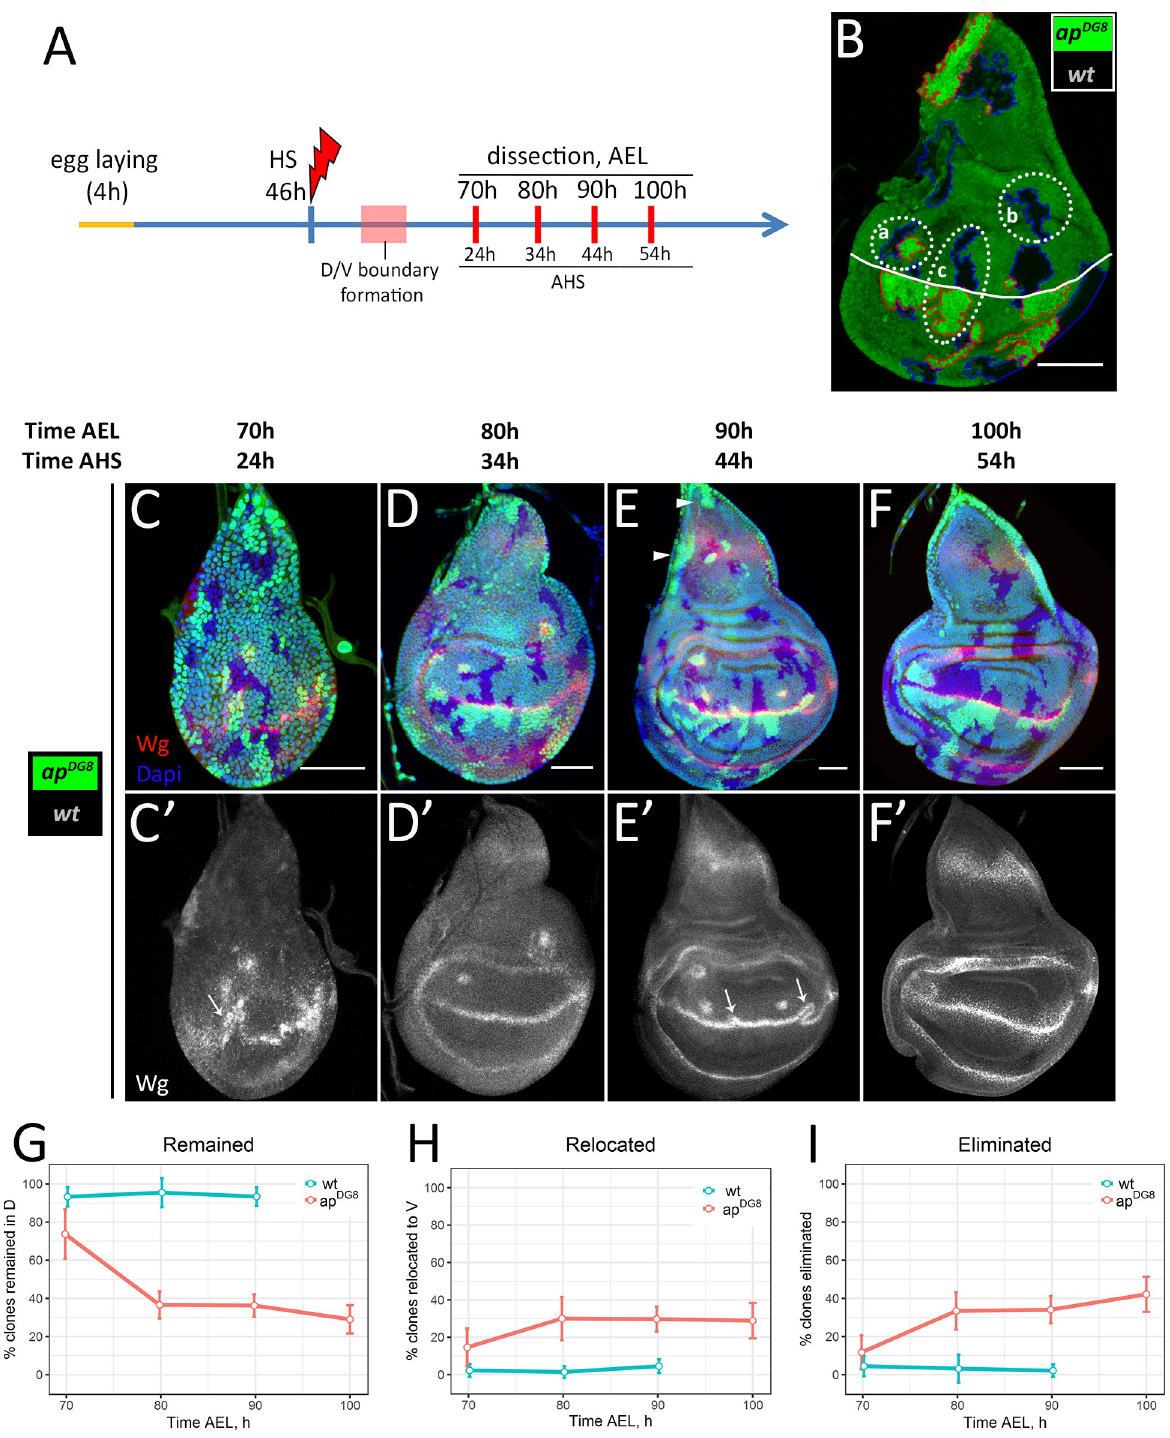
Fig 2. The dynamics of clone elimination. (A) Time-course scheme. (B) Strategy of clonal analysis. Example of the disc with ap mutant (2 copies of GFP, red outline) and wild-type sister (absence of GFP, blue outline) clones. (a)–wild-type clone together with the mutant twin; (b)–wild-type clone without the mutant sister; (c)–wild-type clone with ap mutant sister in the opposite compartment. White line corresponds to the D/V boundary. (C-F) Wing discs of indicated times containing differently marked wild-type and ap DG8 sister clones. (C’-F’) Wg channel of C-F. (G-I) Plots represent amount of dorsal clones that remained in the dorsal part (G), have been relocated to the ventral part (H) or completely eliminated from the disc (I) as a function of time. Number of clones in each group was normalized to the number of dorsally located wild-type clones (per